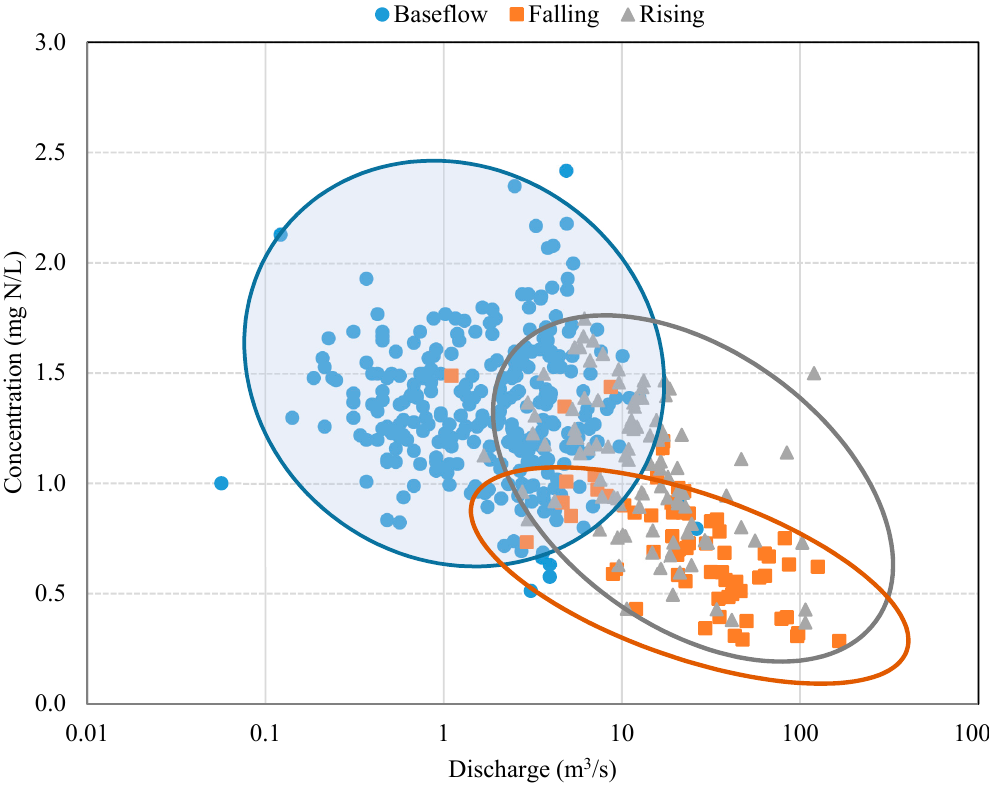
Figure 5. Clustering of various USGS-collected nitrate sample groups. Note that horizontal axis is plotted in logarithmic scale. The ellipses are drawn to visually identify clustering of samples. (m 3 /s).